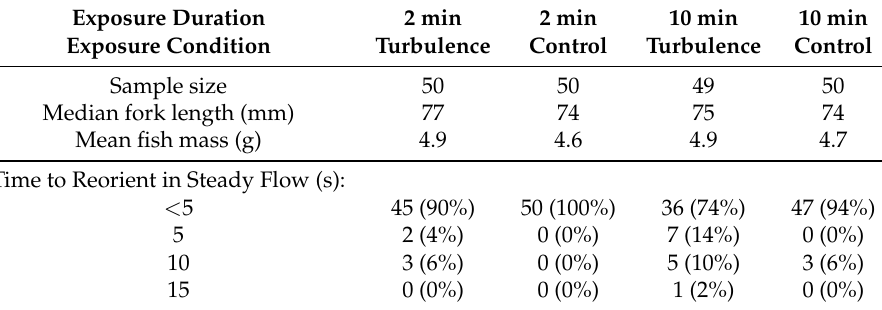
Table 3. Summary of juvenile Chinook salmon morphology and reorientation